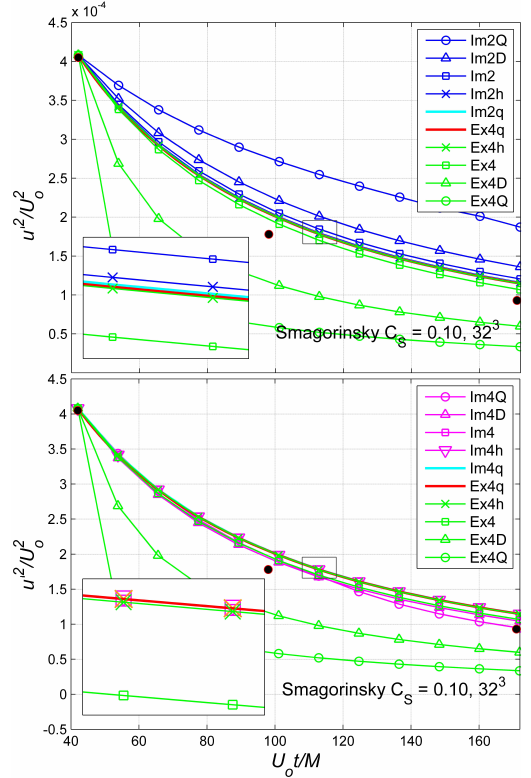
Figure 2. A comparison of the decay of TKE as predicted by the Ex4-Im2 ( above ) and Ex4-Im4 ( below ) methods with various time steps on a 32 3 grid.